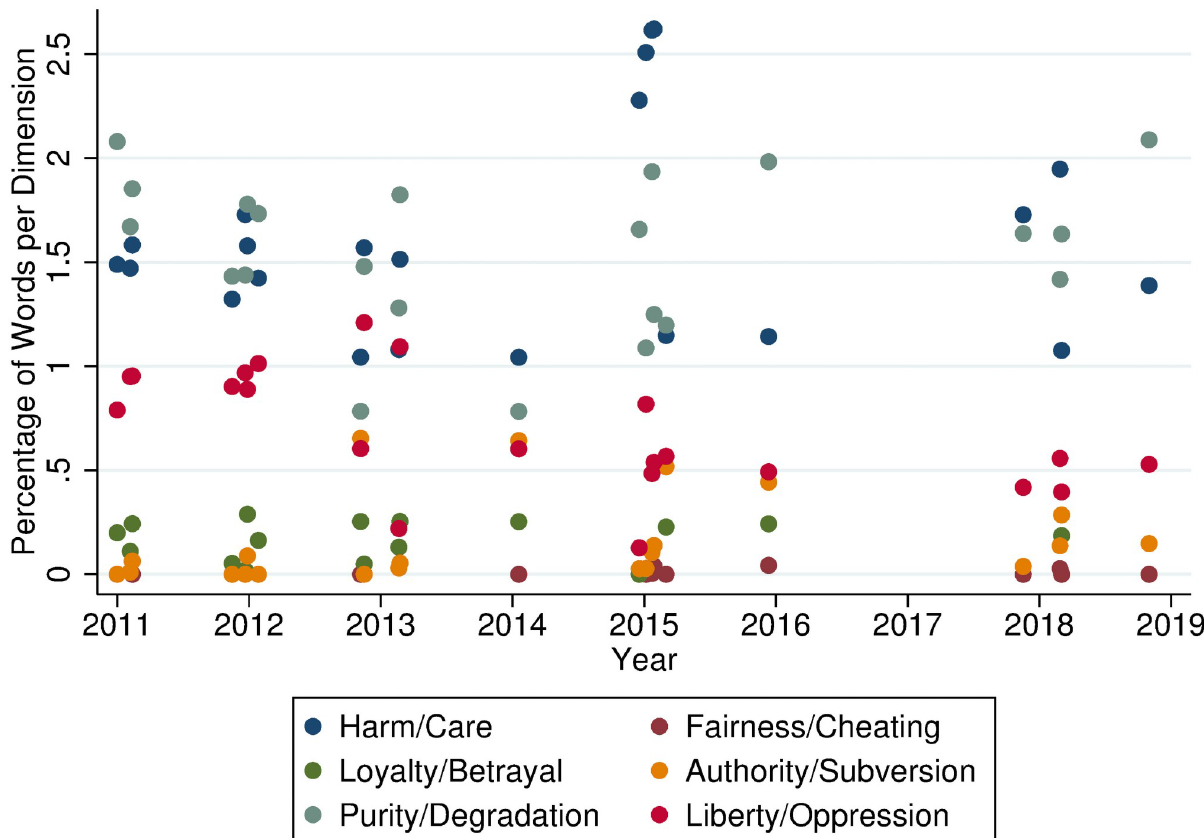
Fig 2. Overview of the dimension loading of the RIVM brochures per year, jittered with 5% noise.